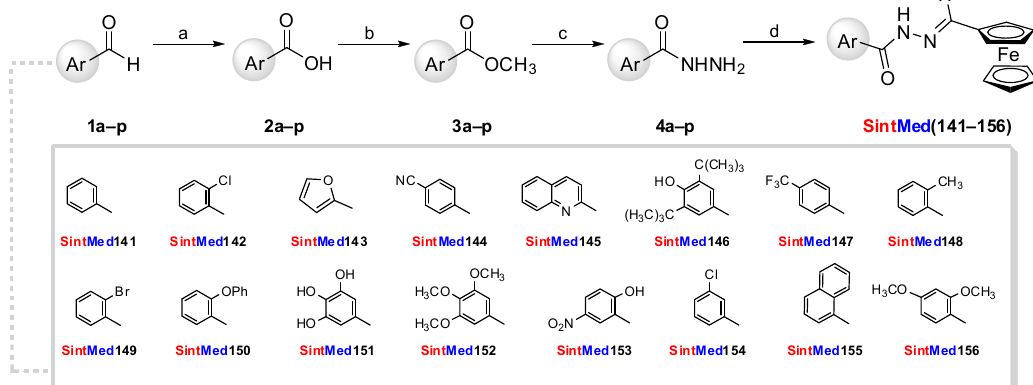
Scheme 1. Synthetic route for the ferrocene- N -acyl hydrazone derivatives.